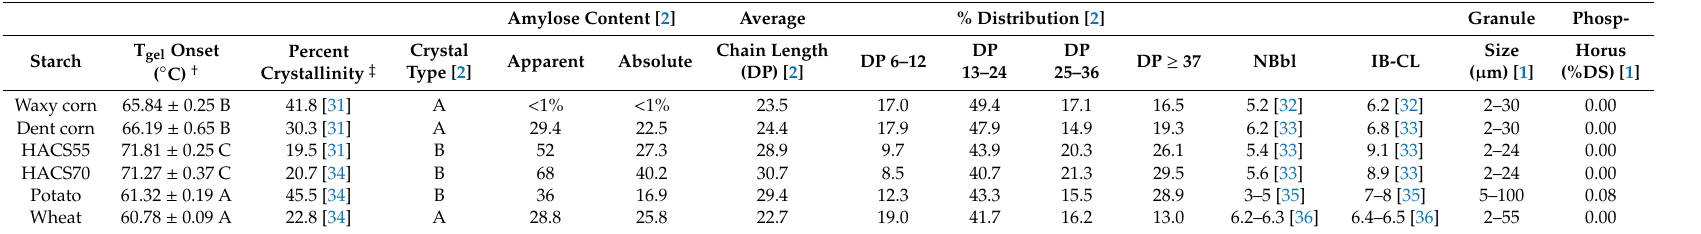
Table 1. Physical and chemical properties of the starches used in this